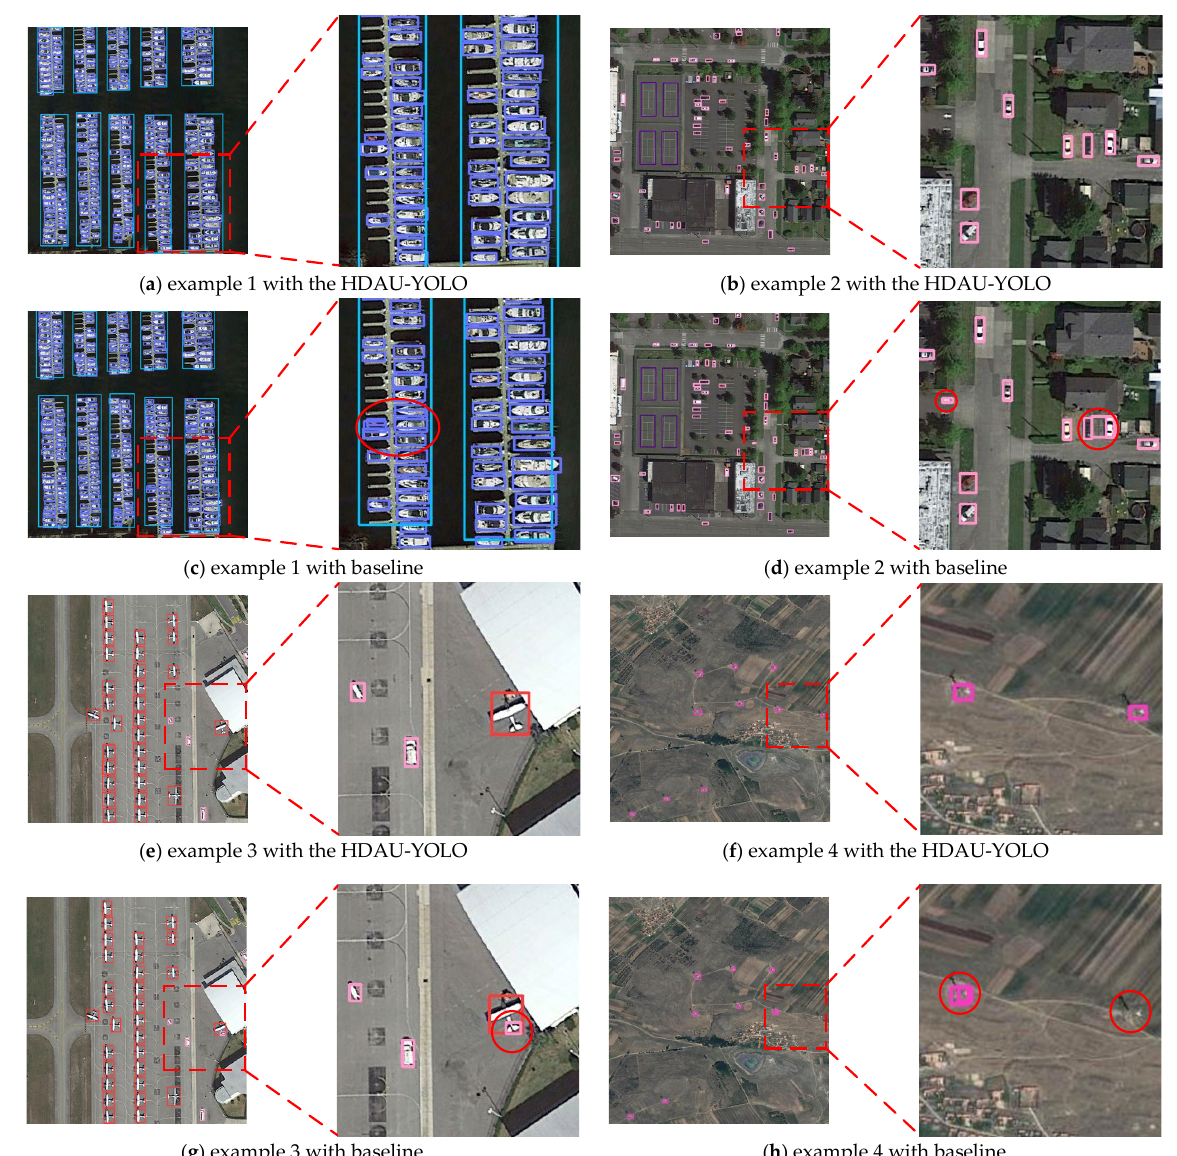
Figure 11. Comparison of small object detection on the DIOR test set.